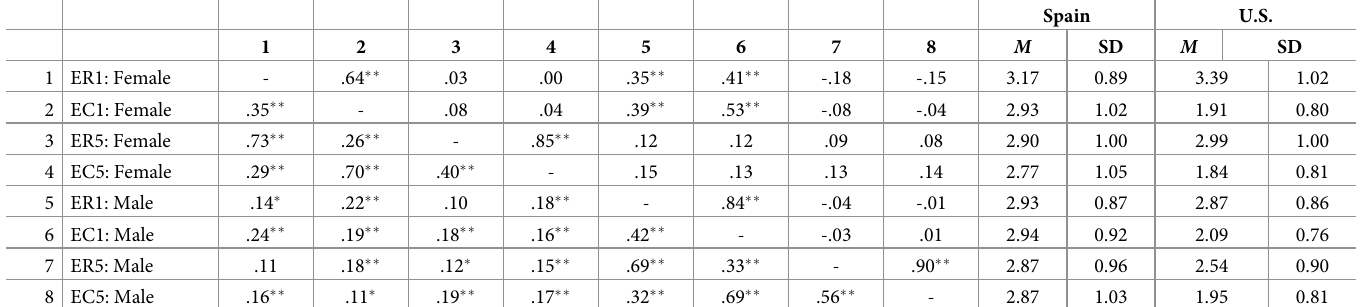
Table 1. Descriptive statistics and correlations for U.S. and Spain women and men DoS subscales of emotional reactivity and emotional cutoff at Time 1 and Time 2.